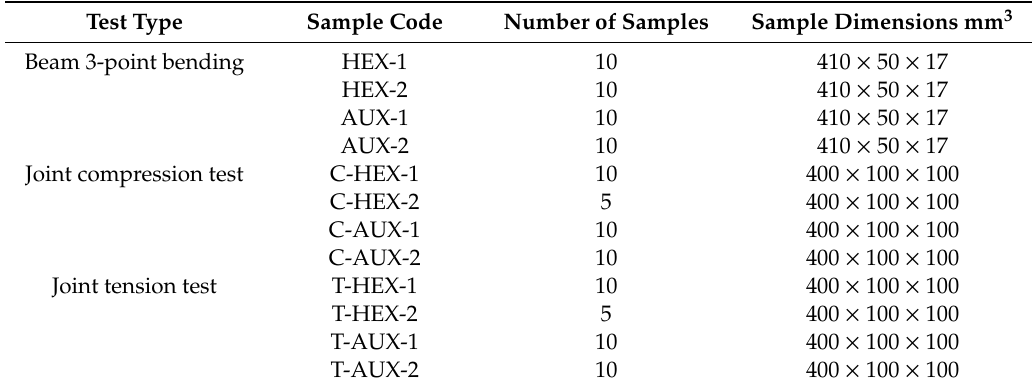
Table 1. Summary of samples prepared for tests.